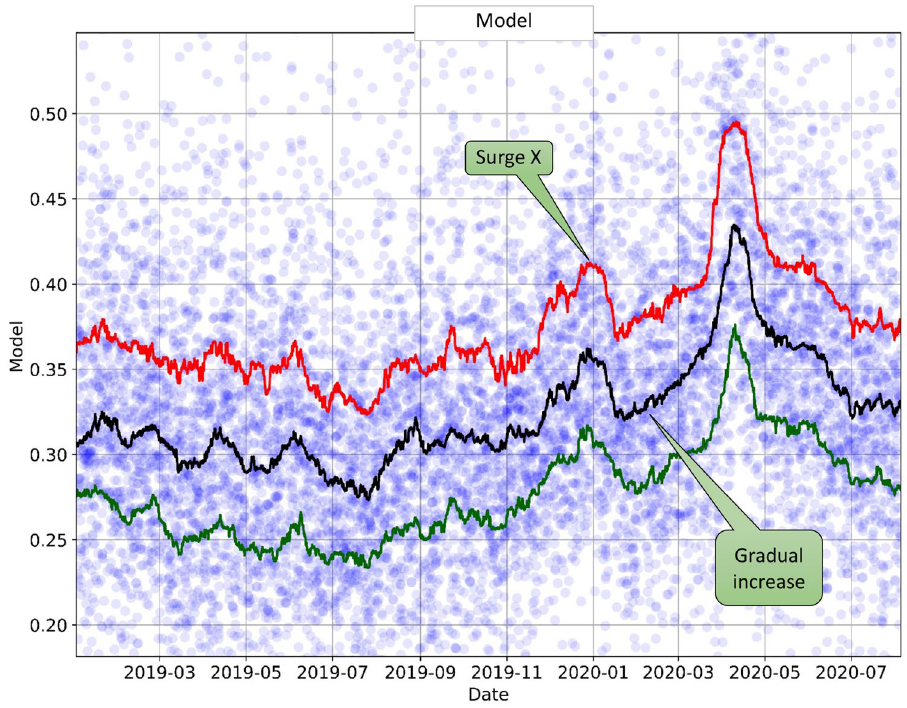
Figure 1. Predicted fraction of patients requiring oxygen within 48 h of ED arrival plotted over time (from January 2019–August 2020). The circles represent the original data averaged over 6-h intervals (with 3-h increments). Lines represent the percentile curves: the 25th percentile (green line), median (black line), and 75th percentile (red line). The percentile trend curves exhibit temporal patterns despite the large data variability and